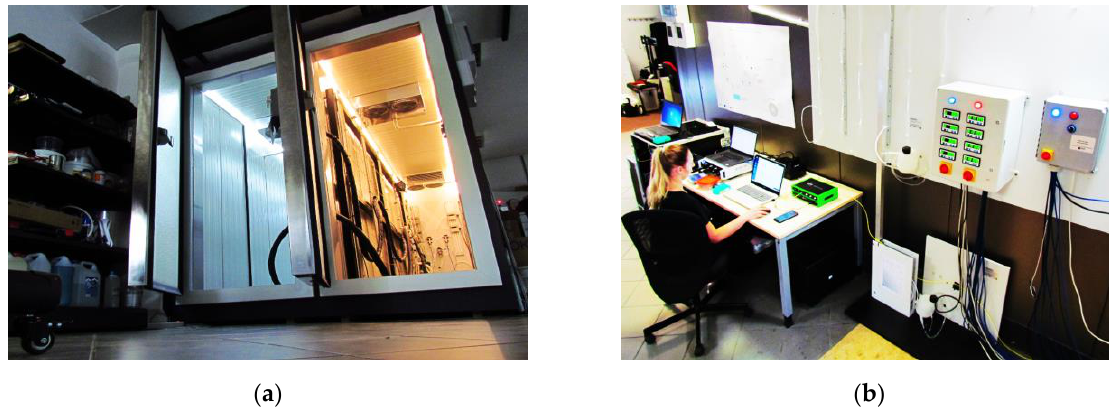
Figure 11. ( a ) Front view of dual-zone thermal chamber (with doors opened); ( b ) a stand for control and operating distributed fiber optic sensing and other measurement techniques during experiments.